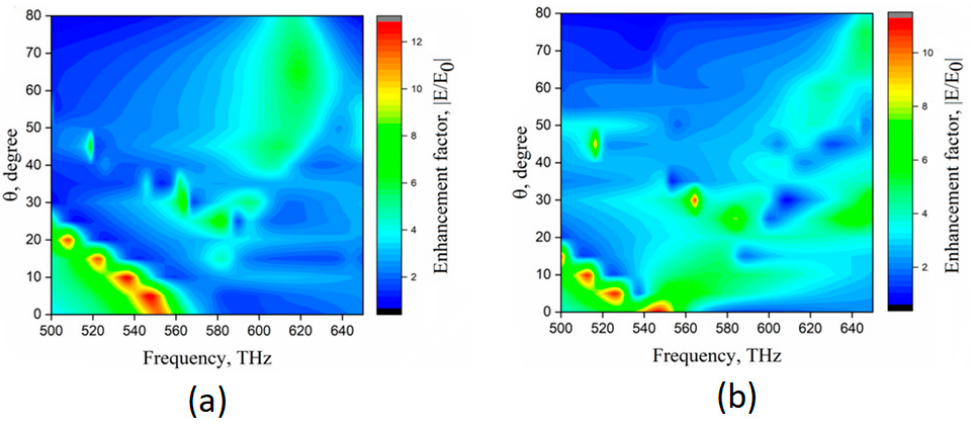
Figure 4. Enhancement factor versus θ and frequency, ( a ) for TE-mode measured by Probe_1 and ( b ) for TM − mode measured by Probe_2.